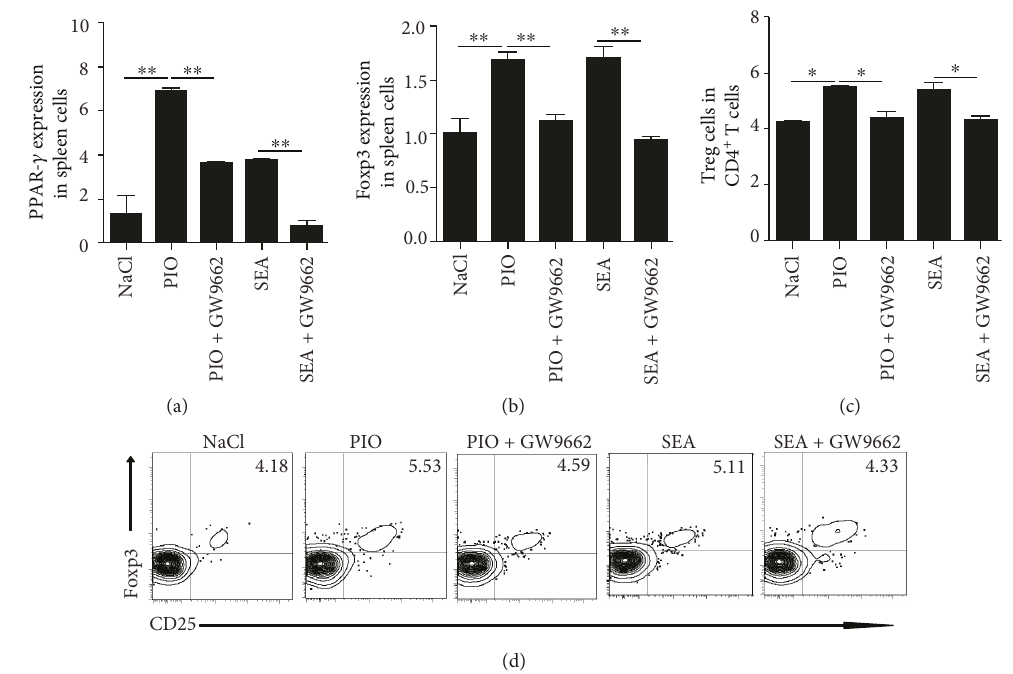
Figure 3: The expression of Foxp3 and Treg cells after pioglitazone or (and) SEA stimulation in vitro. (a, b) Splenocytes from WT mice were prepared and stimulated by pioglitazone (PIO, 10 μ g/ml) and a PPAR- γ antagonist (GW9662, 2ng/ml) with or without SEA (25 μ g/ml) stimulation for 24 h, and then the mRNA level of PPAR- γ and Foxp3 were analyzed by RT-PCR. (c, d) The percentage of Treg was detected after pioglitazone treatment in spleen cells with or without SEA stimulation for 24 h. All experiments were repeated three times with similar results (ANOVA/LSD). ∗ P < 0 05 and ∗∗ P < 0 01